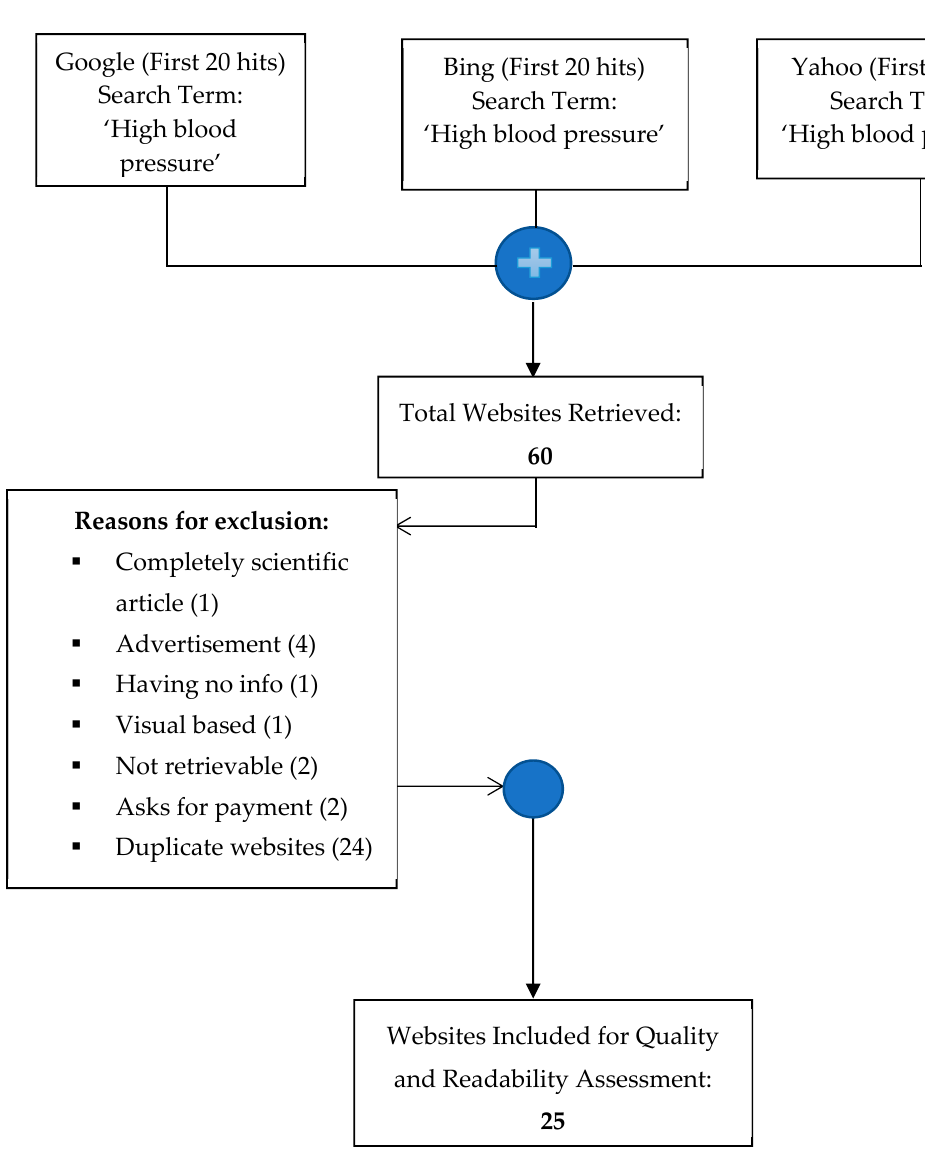
Figure 1. Flow chart of research work. Table 1. Categories of websites.